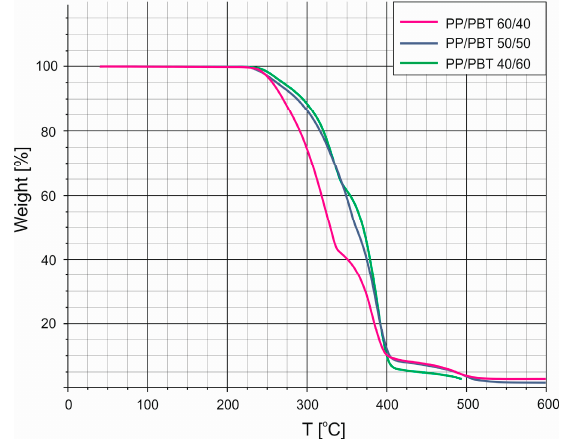
Figure 5. Non-isothermal analysis of TG thermograms of uncompatibilized polypropylene / poly(butylene terephthalate) (PP / PBT) blends.